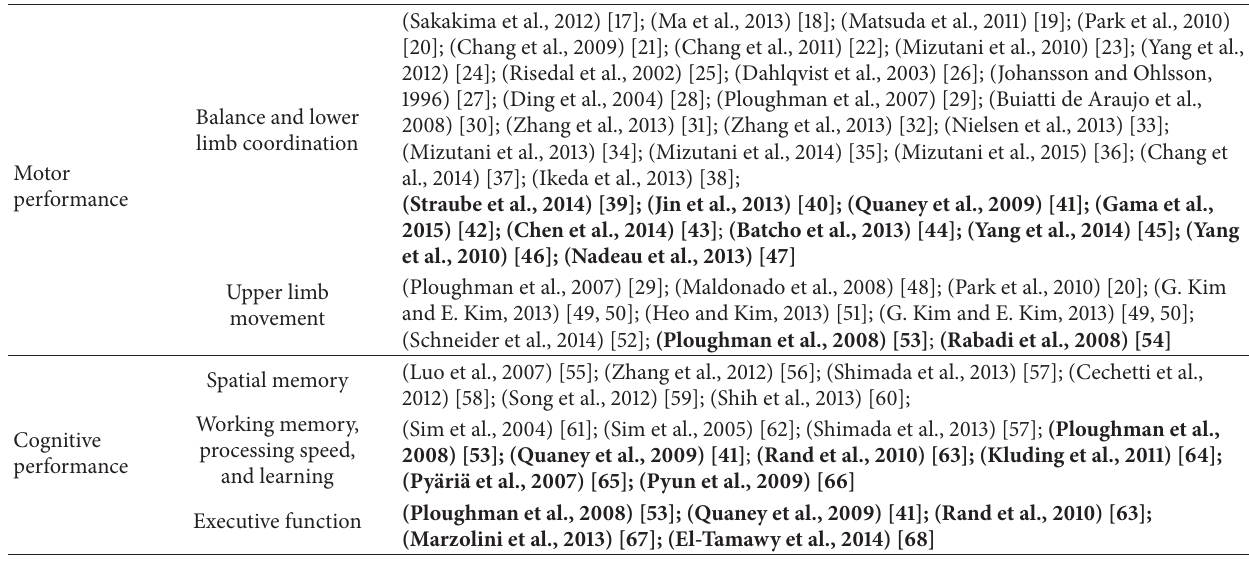
Table 1: Summary of search results by theme (clinical trials in bold lettering).